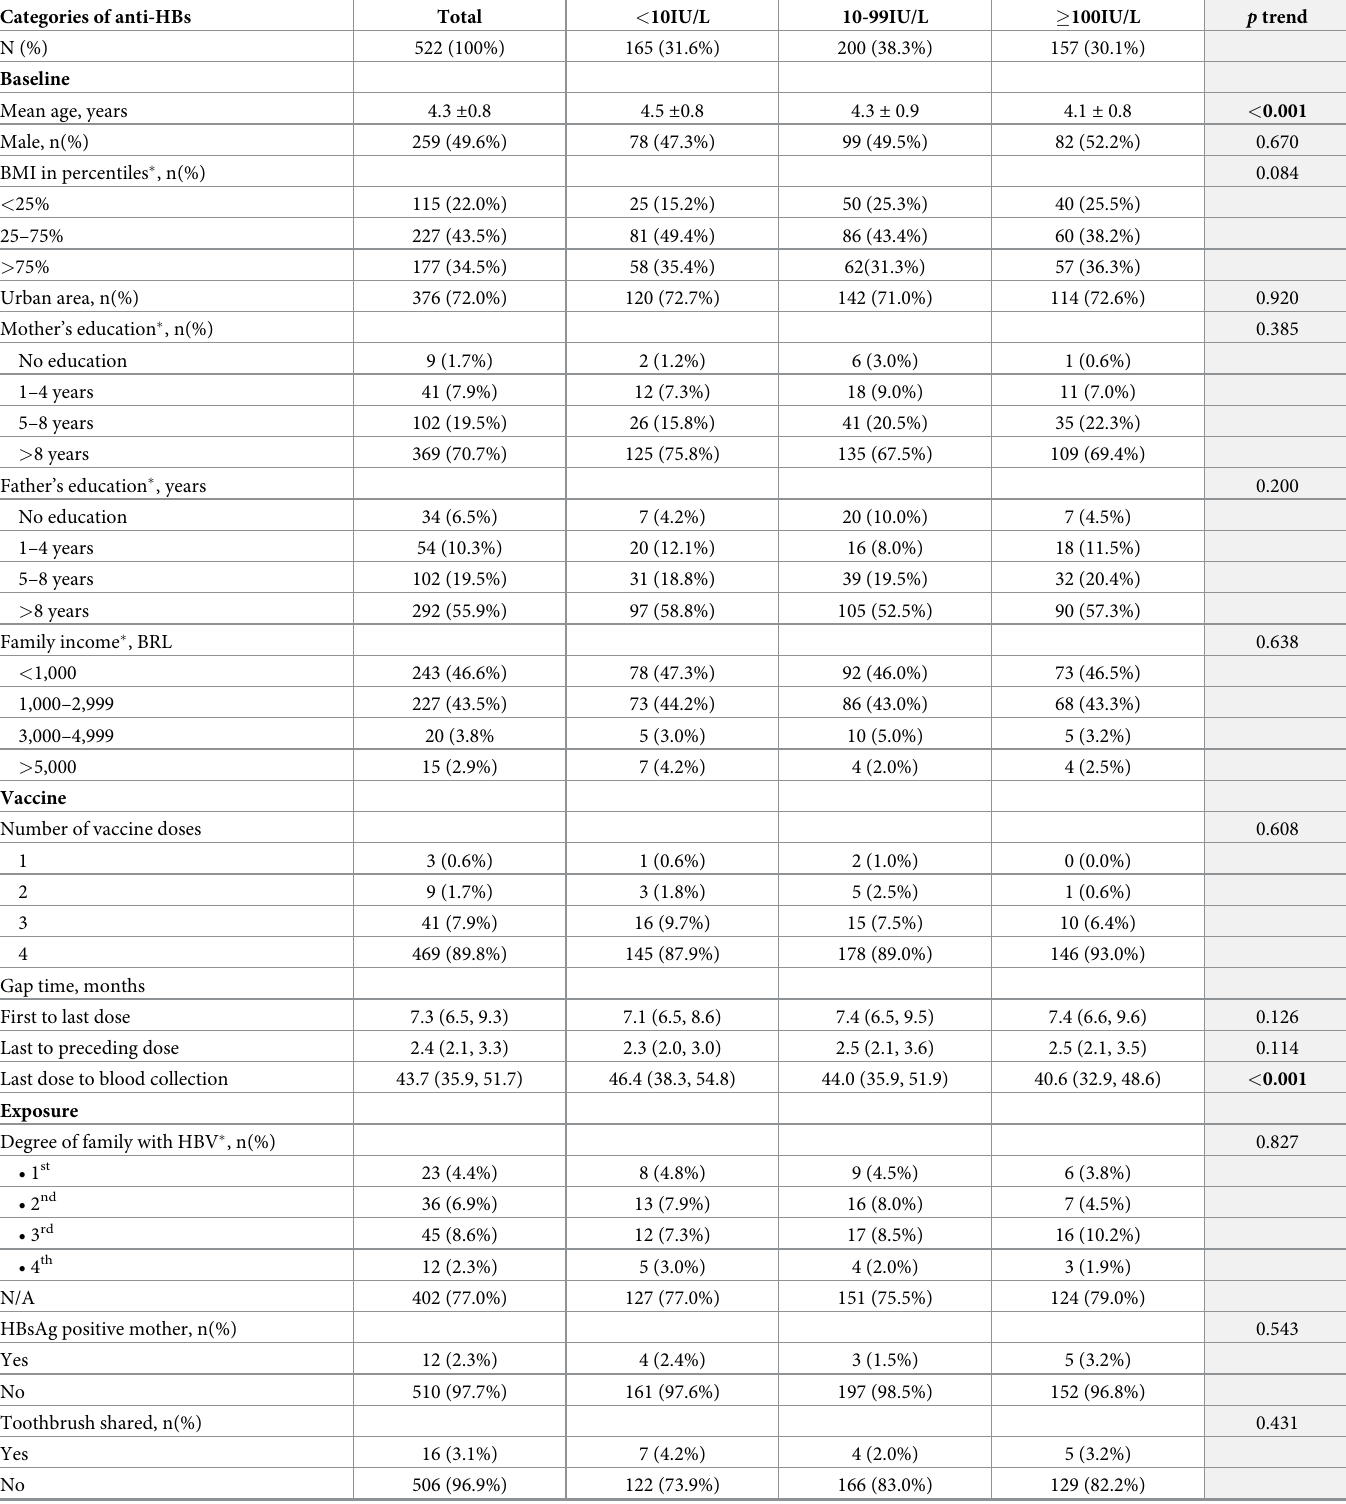
Table 1. Baseline information about children, their hepatitis B vaccine schedule and potential factor of risk to exposure to HBV, stratified by anti-HBs